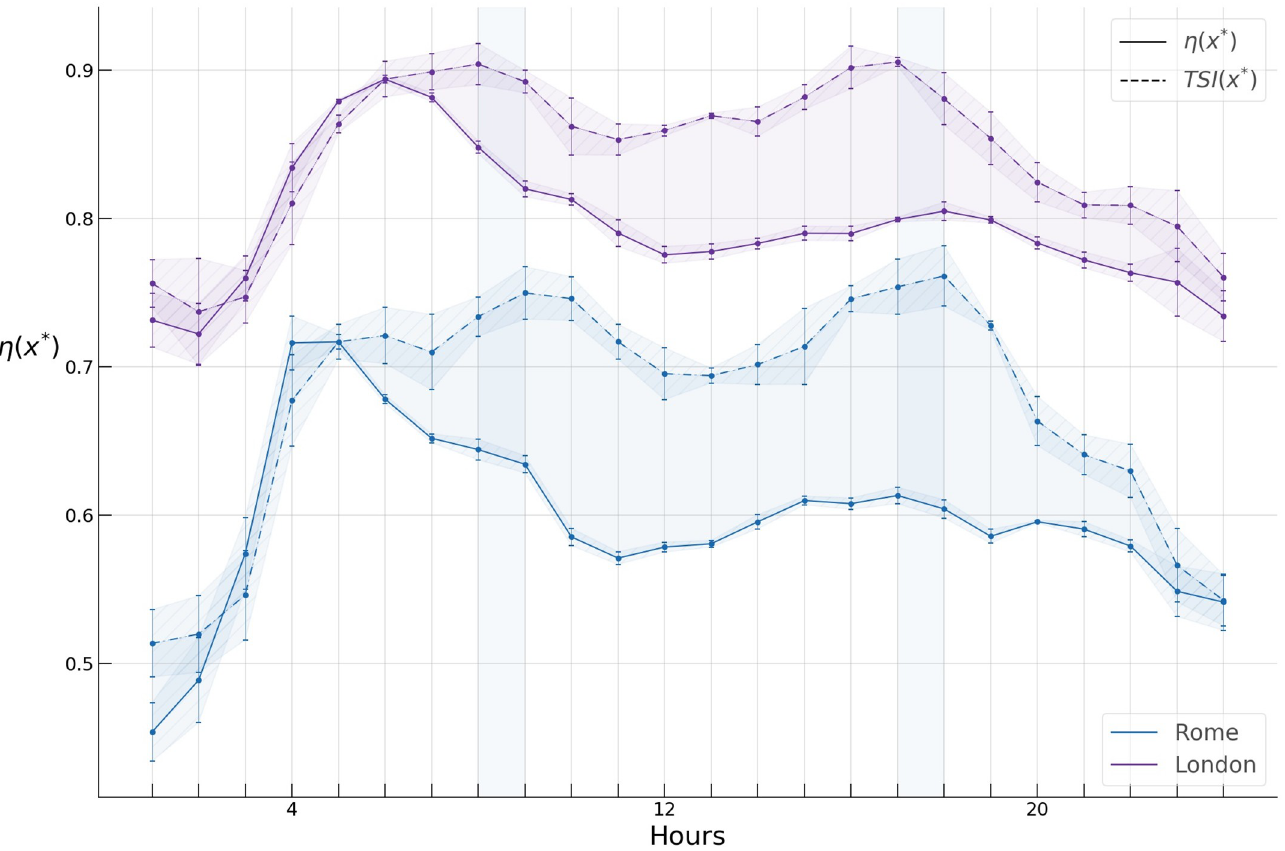
Fig 13. Spreading index and time-space spreading index ( TSI ) with corresponding 95% confidence intervals during a typical day in Rome and London.